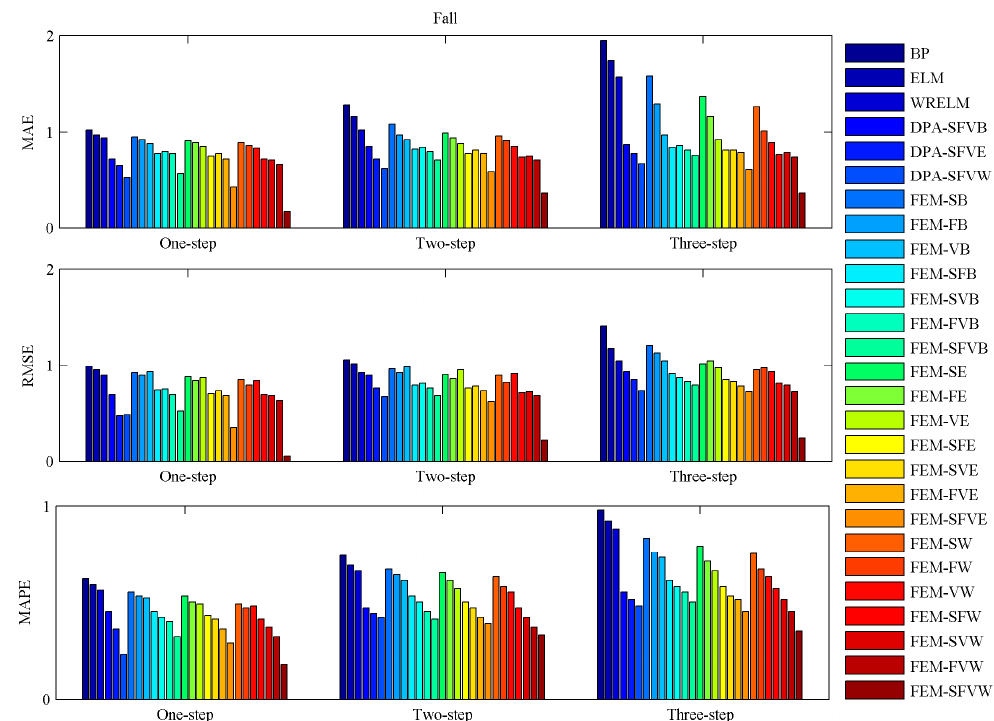
Figure 13. Performance comparison of different models in terms of MAE, RMSE and MAPE in fall.